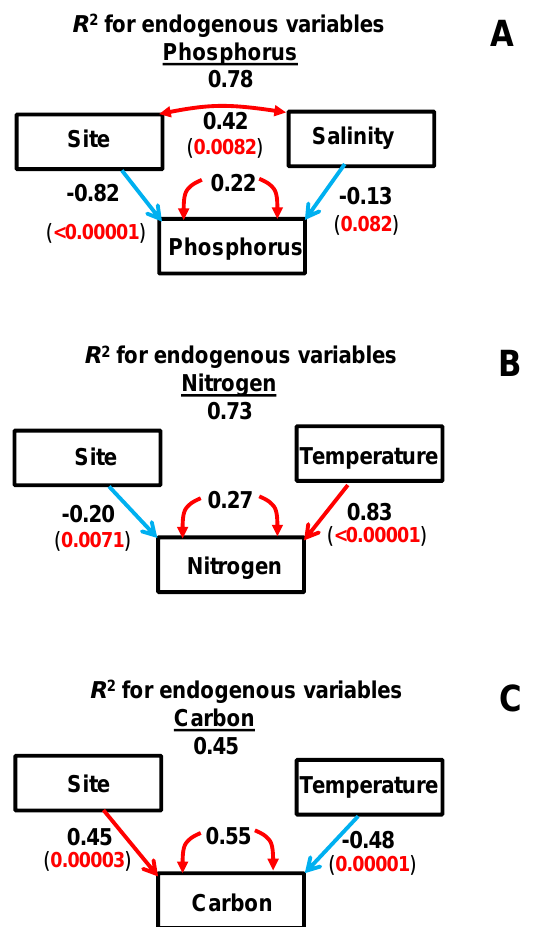
Figure 6. Diagrams of the structural equation models that best explained the maximum variance of the elemental composition of the straw during decomposition with habitat (ridges and ditches) and Phosphorus ( A ); Nitrogen ( B ); and Carbon ( C ) concentrations in residual litter as exogenous factors. Positive relationships ware indicated with blue arrows and negative relationships with red arrows.